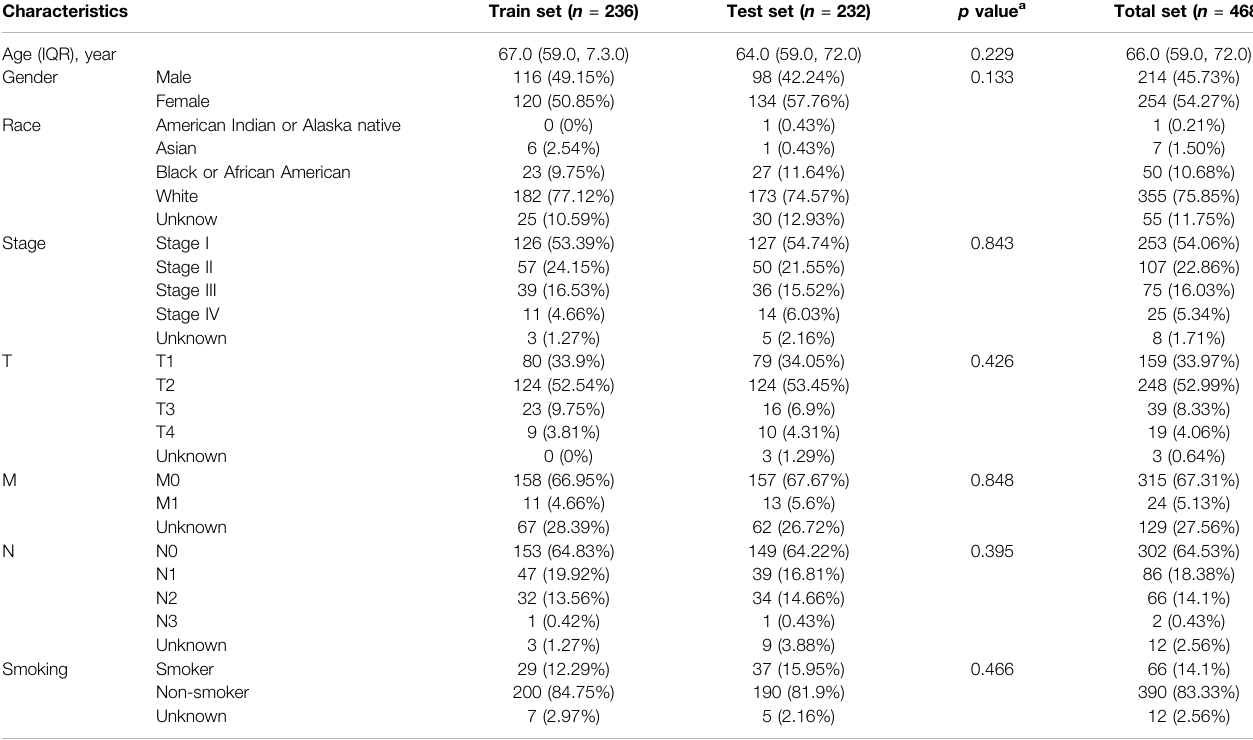
TABLE 1 | Characteristic of LUAD patients in train, test and all TCGA data set. Characteristics